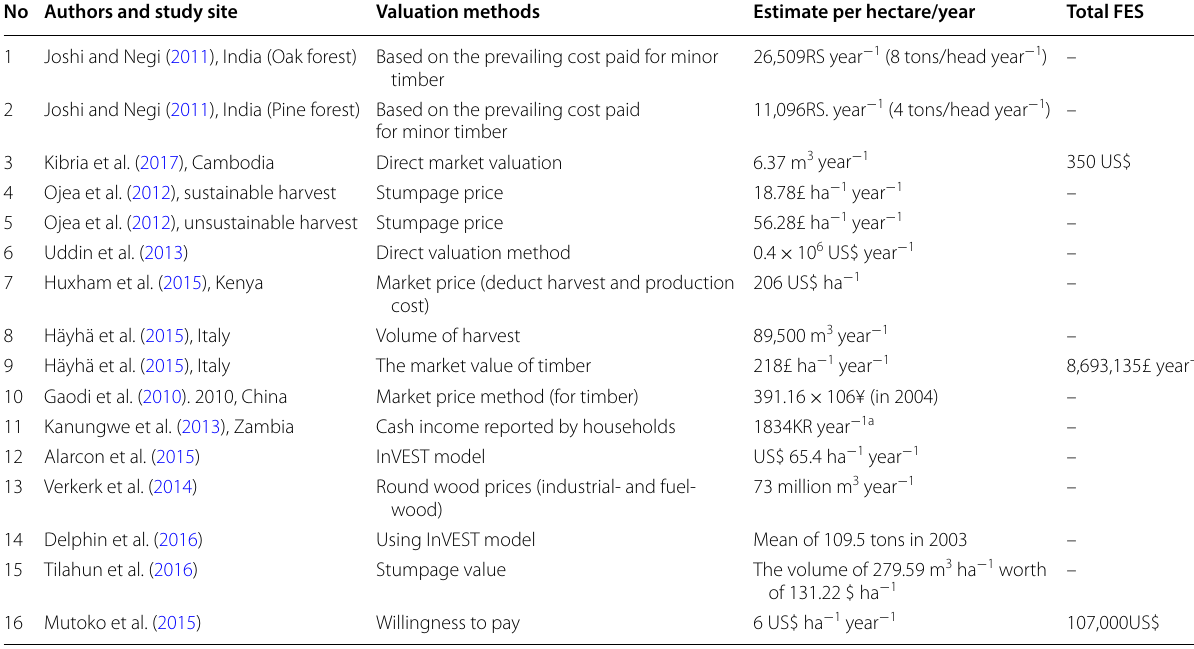
Table 4 Reviewed studies dealing with timber production including its methodology and monetary